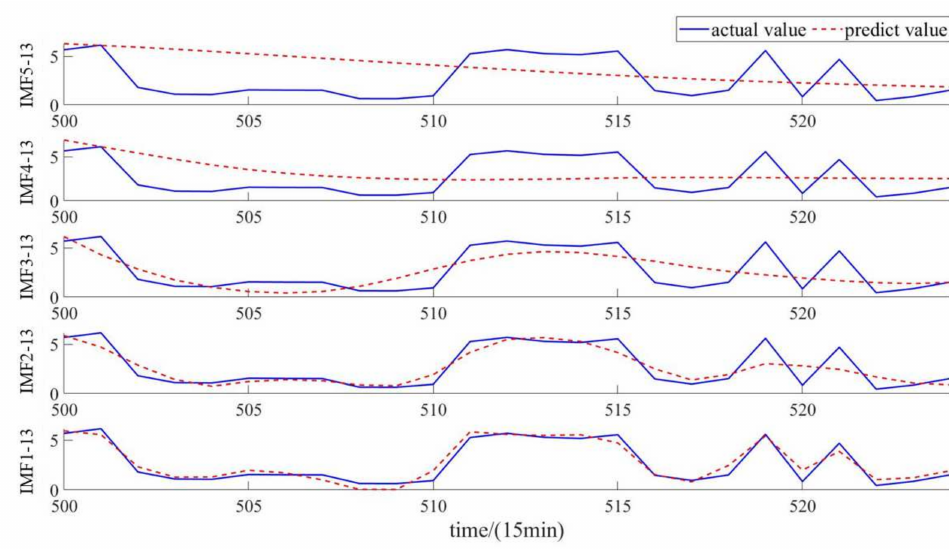
Figure 12. Process of reactive power signal reconstruction by feature superposition ( IMF 5 − 13